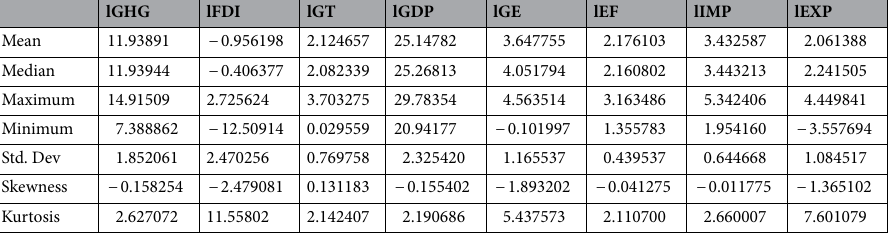
Table 2. Descriptive